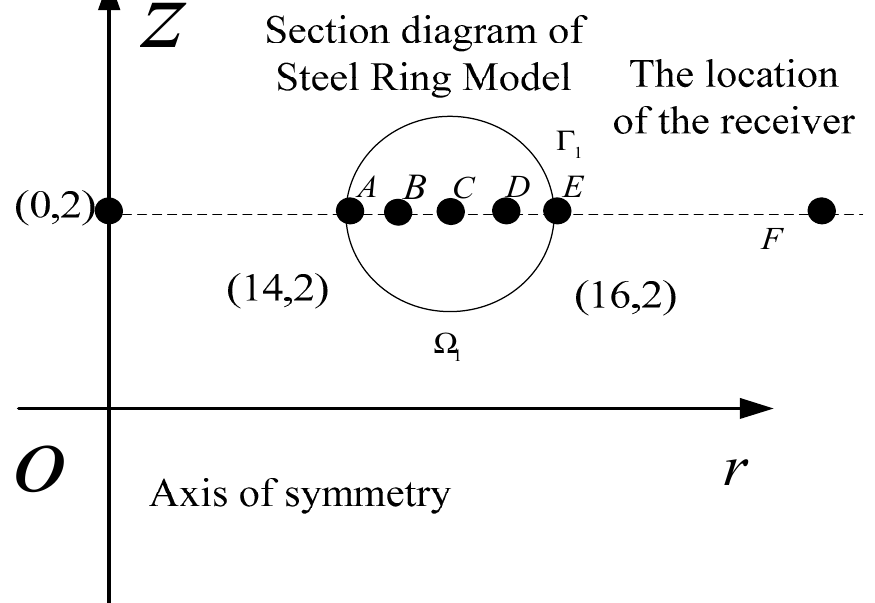
Figure 2. Schematic diagram of the steel ring model .